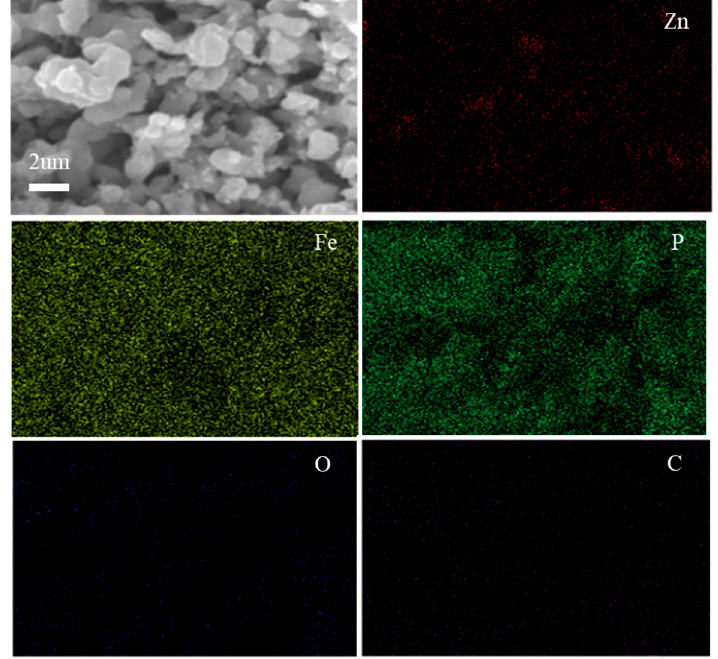
Figure 3. Elemental mapping results of LiFePO 4 /C-xZnO (x = 3 wt%) sample.